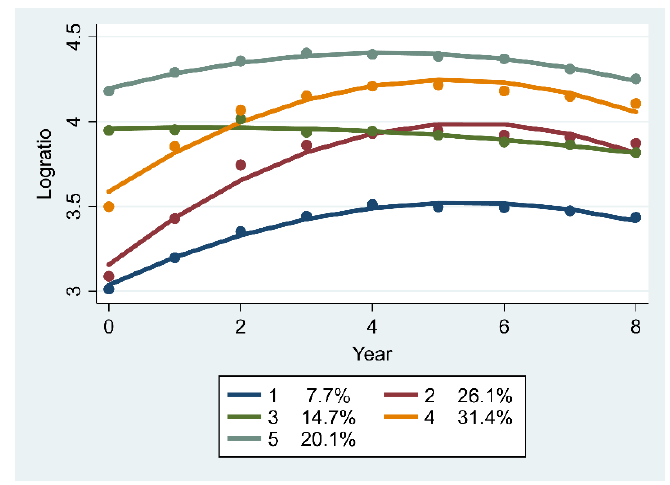
Figure 4. Trajectories of the log-transformed ratio of output to workforce for public health services ( n = 571).